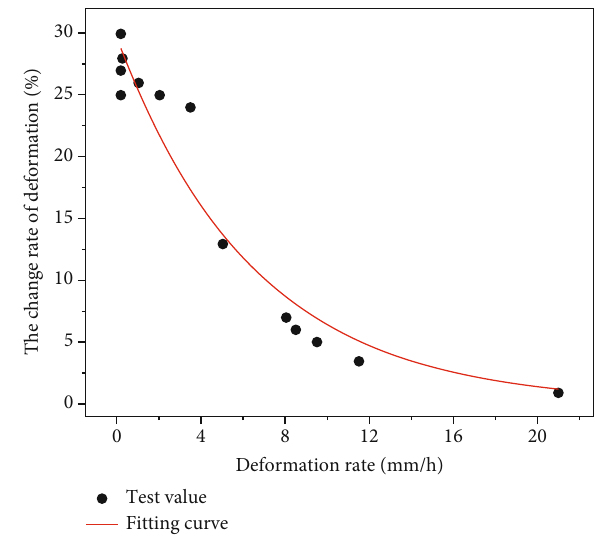
Figure 19: Relation between the change rate of deformation and deformation rate of